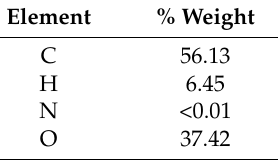
Table 1. Tar elemental composition as from the experimental test.